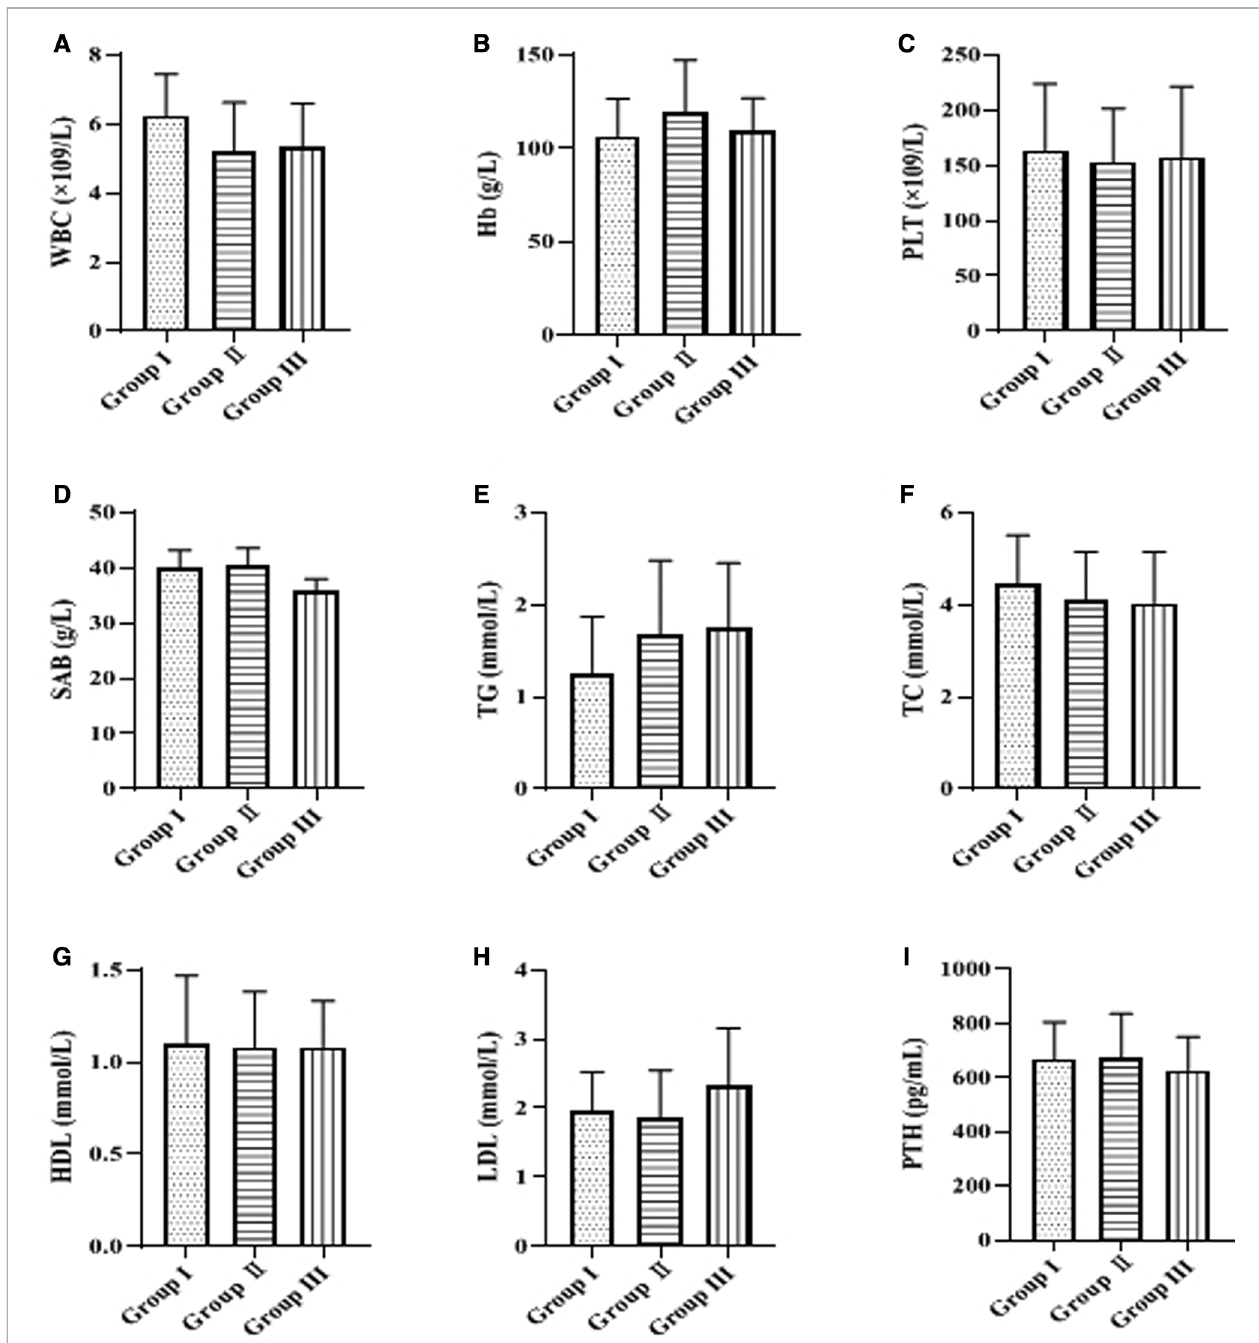
FIGURE 1 | Comparison of clinical and biochemical indexes. The levels of white blood cells (WBC), hemoglobin (Hb), platelets (PLT), serum albumin (SAB), triglycerides (TG), total cholesterol (TC), high-density lipoprotein (HDL), low-density lipoprotein (LDL), and parathyroid hormone (PTH) are indicated in descending order from A to I